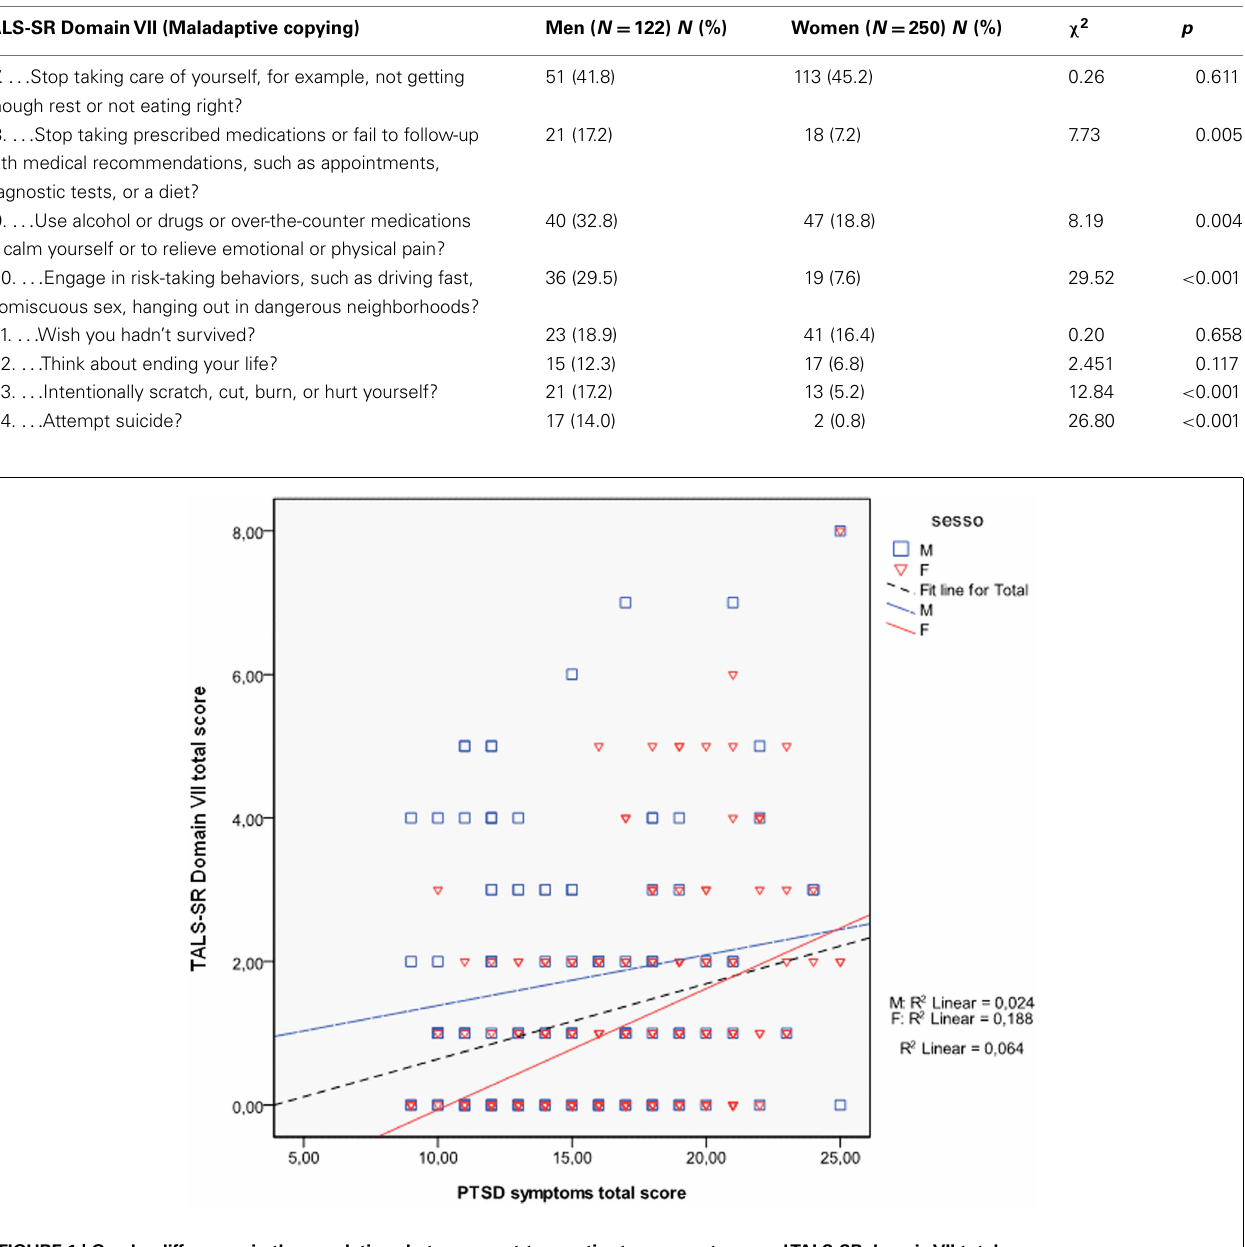
FIGURE 1 | Gender differences in the correlations between post-traumatic stress symptoms andTALS-SR domainVII total